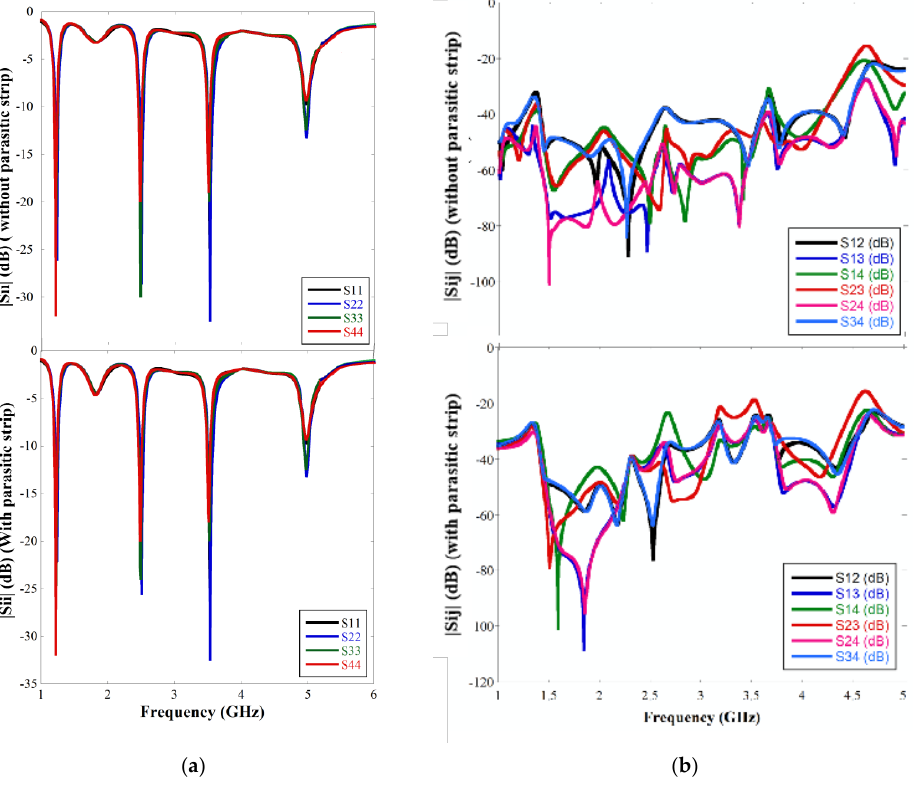
Figure 7. ( a ) |Sii| graph and ( b ) |Sij| graph of the four element MIMO with and without parasitic cross microstrip line. Table 4. Comparison table of gain parameter of the four element MIMO antenna with and without parasitic cross microstrip line.